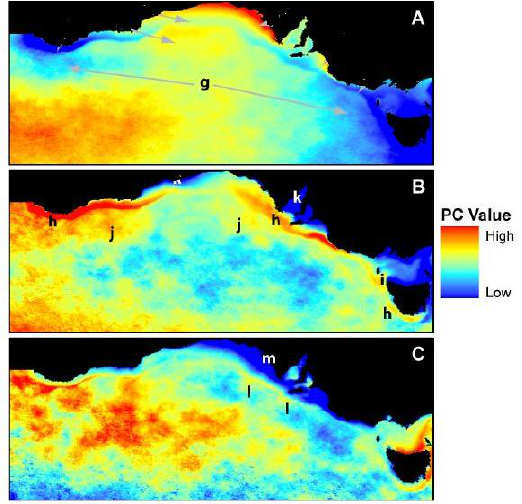
Figure 2: Southern Australian SST sPCA components: